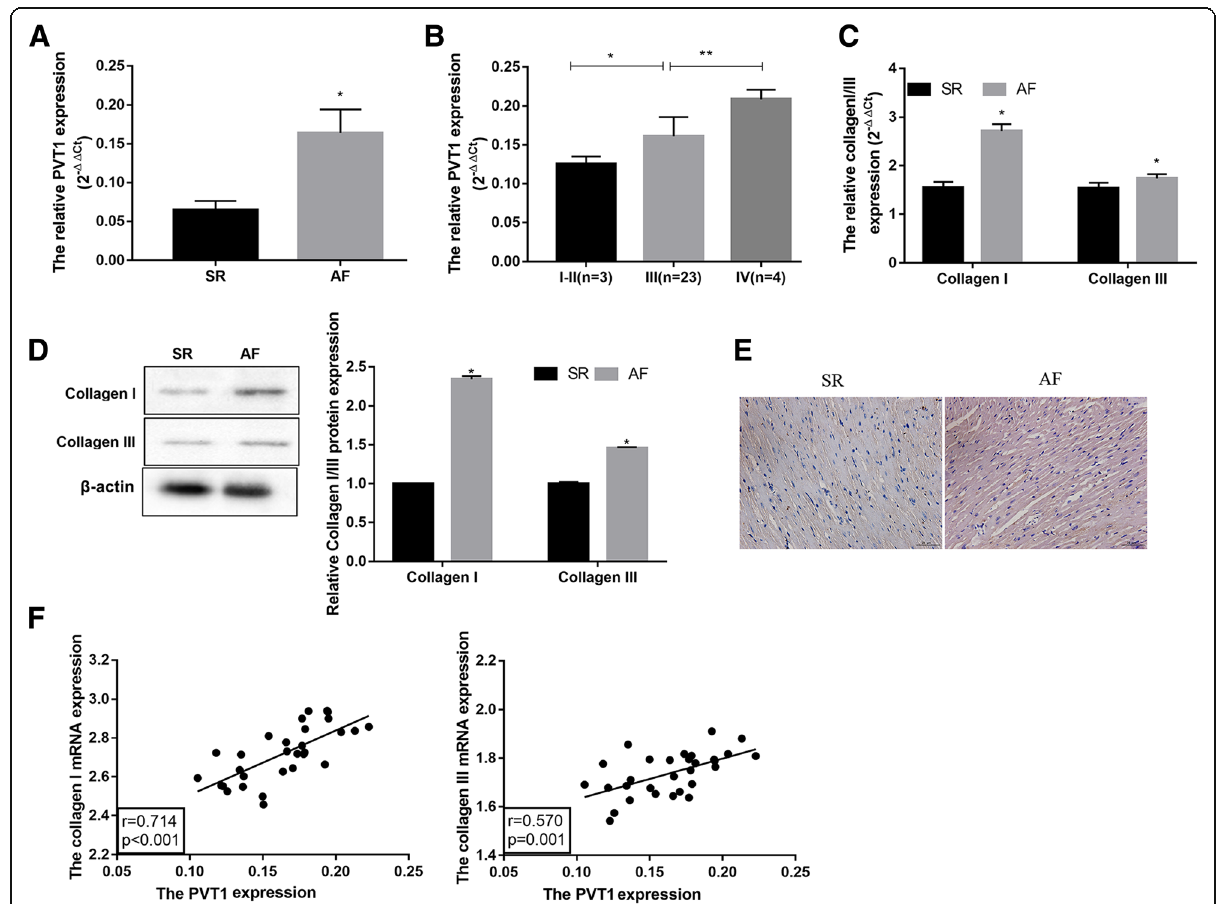
Fig. 1 PVT1 is increased in AF patients and positively with collagen I and collagen II. The atrial muscle tissues were collected from SR ( n = 20) and AF patients ( n = 30) and subjected to the following experiments. a qRT-PCR analysis of PVT1 expression in human atrial muscle tissues. b qRT-PCR analysis of PVT1 expression from AF patients with different cardiac function classification (NYHA I-IV). PVT1 expression was gradually elevated with the increase of cardiac function classification. c qRT-PCR analysis of Collagen I and Collagen III mRNA levels in human atrial muscle tissues. d Western blot analysis of Collagen I and Collagen III protein levels in human atrial muscle tissues. β -actin served as the loading control. e Immunohistochemistry analysis of Collagen I showing the Collagen I-positive signal (brownish-yellow granules). Scale bar: 25 μ m. f The positive correlation between PVT1 and Collagen I/III expression in human atrial muscle tissues from AF patients. a , c - f * P < 0.05 vs. SR; b * P < 0.05 and ** P < 0.01. Data are presented as mean ± SD. SR, sinus rhythm; AF, atrial fibrillation; PVT1, plasmacytoma variant translocation